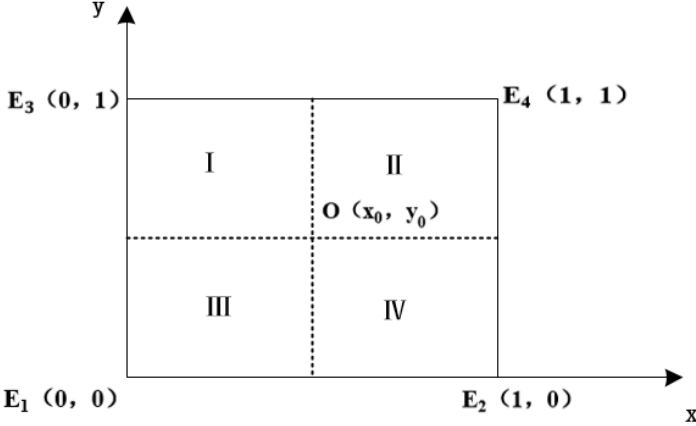
Figure 1. Diagram of the evolutionary game interval and equilibrium point.